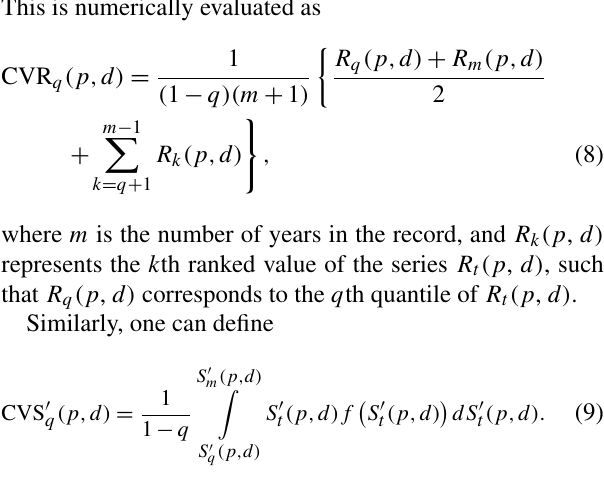
Figure 2. Effective 10-year-return level according to the non- stationary GEV distribution for the Highland Valley